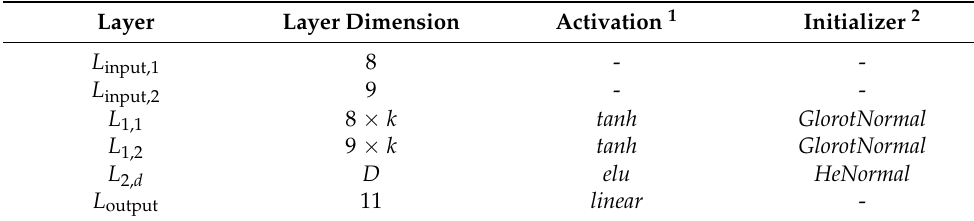
Table 1. Structure of the neural network.